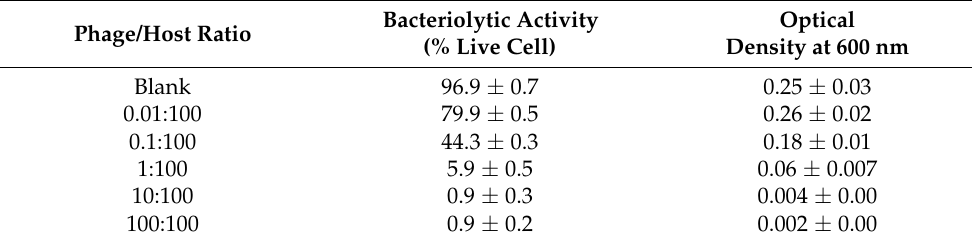
Table 1. Effect of phage to host ratio on bacteriolysis in invitro. Phage/Host Ratio